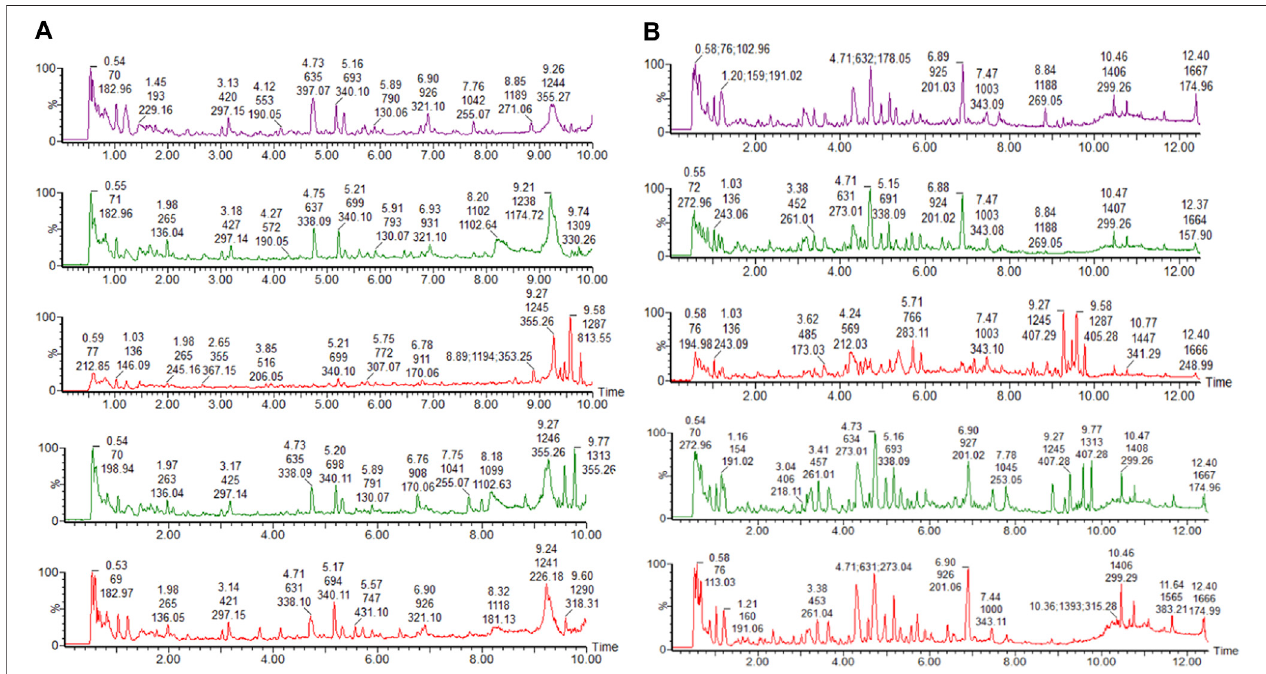
FIGURE 3 | Urine chromatogram of rats in the model group on days 0, 14, 16, 23, 30 (from top to bottom). (A) positive ion mode; (B) negative ion mode.